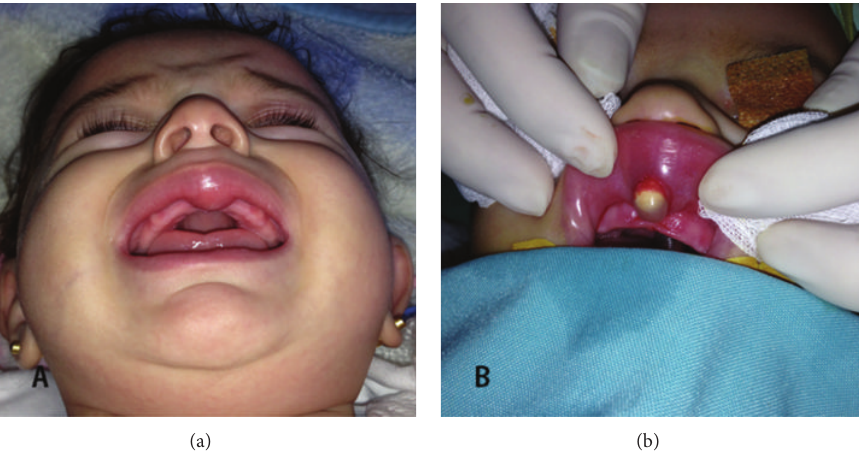
Figure 1: (a) Infant patient with swelling in the upper lip. Lesion located under the philtral columns in the gingiva-buccal mucosal area of the upper lip. (b) Perioperative surgical excision of the lesion.